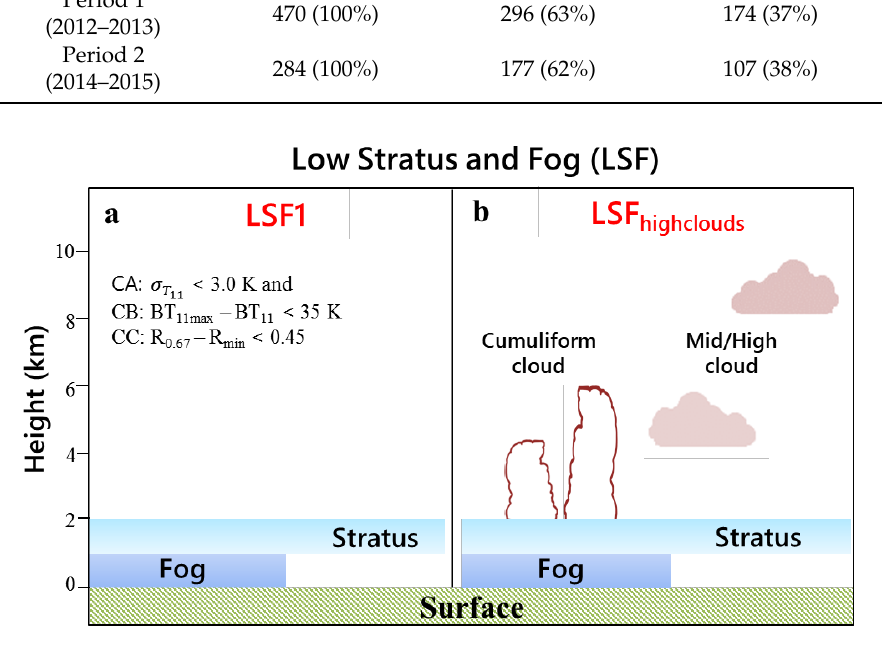
Table A5. Number of LSF cases that are used to develop and validate the optimum thresholds at the beginning of this study. The LSF1 and LSF highclouds cases are shown for Period 1 and Period 2, respectively. The values in parentheses indicate the ratios (%) of the corresponding LSF types to the whole cases. Since the thresholds are not sensitive to the periods (i.e., interannual variation), the whole-period threshold values have been used in this study.